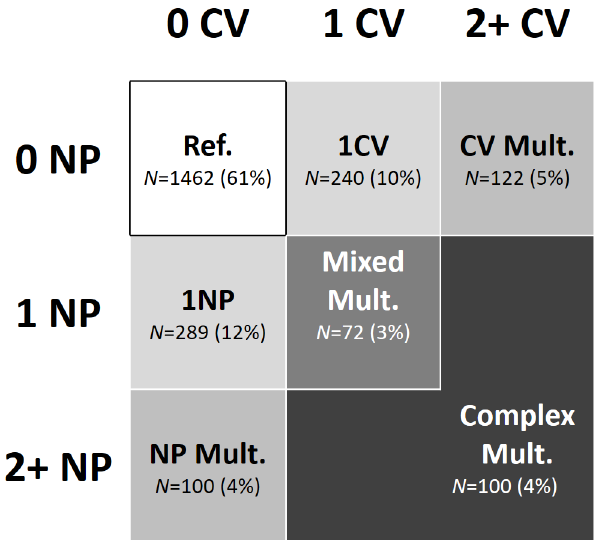
Fig 2. Model showing the grouping of chronic diseases. Participants were grouped by patterns of chronic diseases; that is, by number of CV and NP diseases. CV, cardiovascular; Mult., multimorbidity; NP, neuropsychiatric; Ref., reference